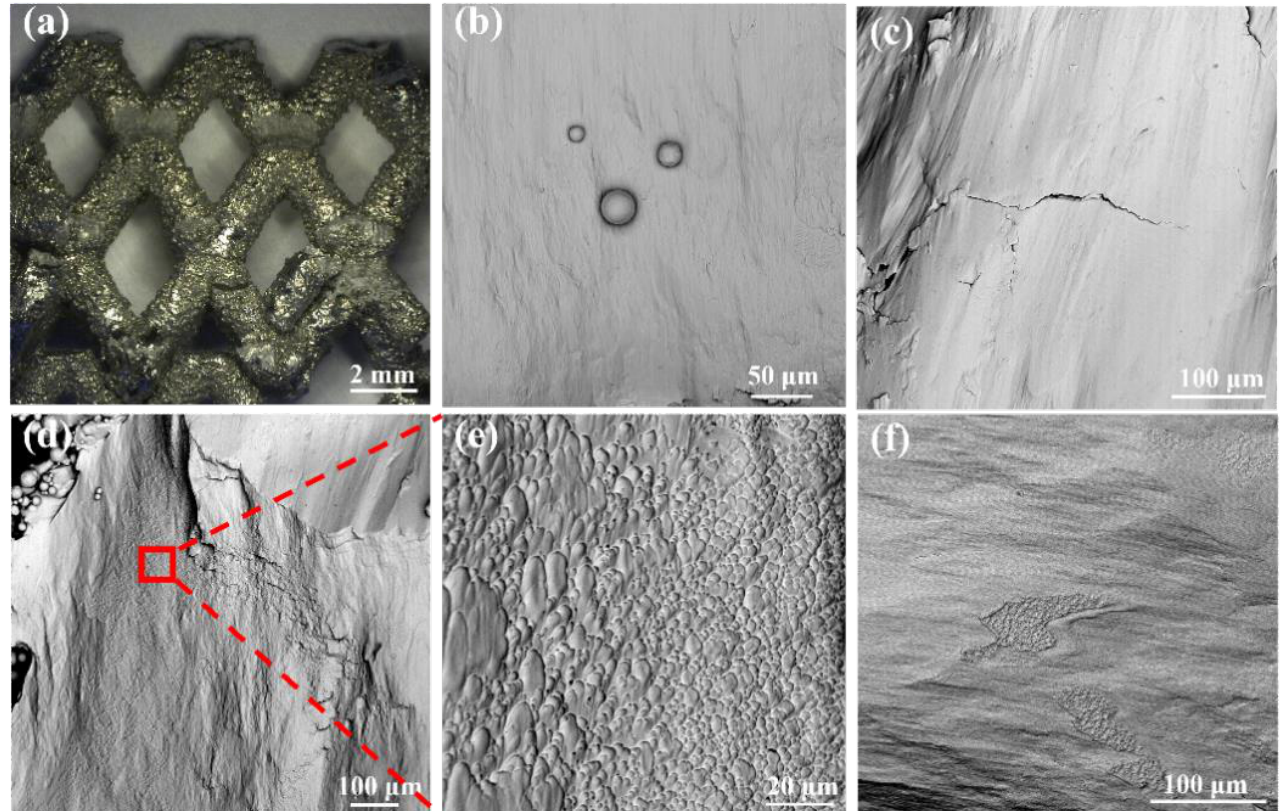
Figure 8. ( a , b ) are the macroscopic morphology of the representative specimen observed using OM and the splash defects observed by SEM, respectively, after the compression experiments. ( c , d , f ) show the nodal fracture morphology of UTD, INDEX, and UNIFORM lattice structures observed by SEM, respectively, where ( e ) is a local enlargement of the fracture morphology of INDEX lattice structure.